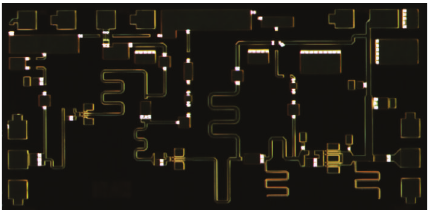
Figure 4: Photograph of the fabricated pHEMT MMIC power